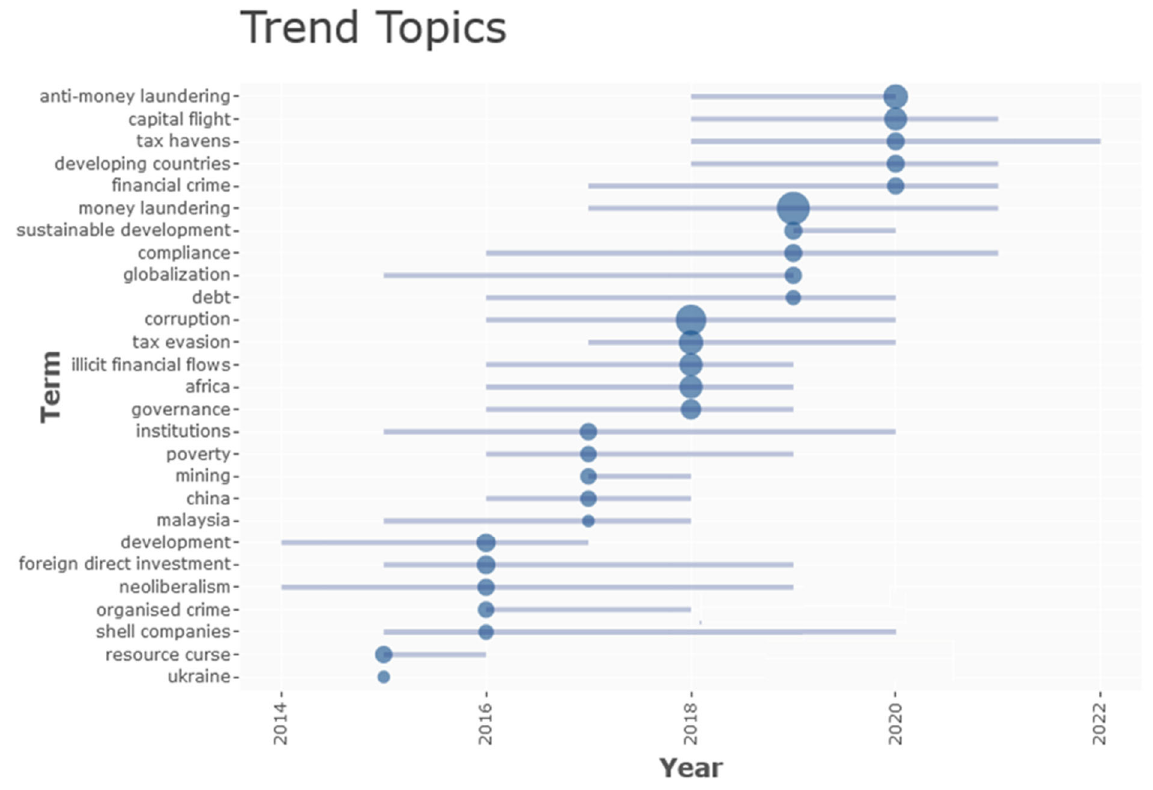
Figure 6. Trending topics between 2014–2022. Source: Scopus/Biblioshiny.